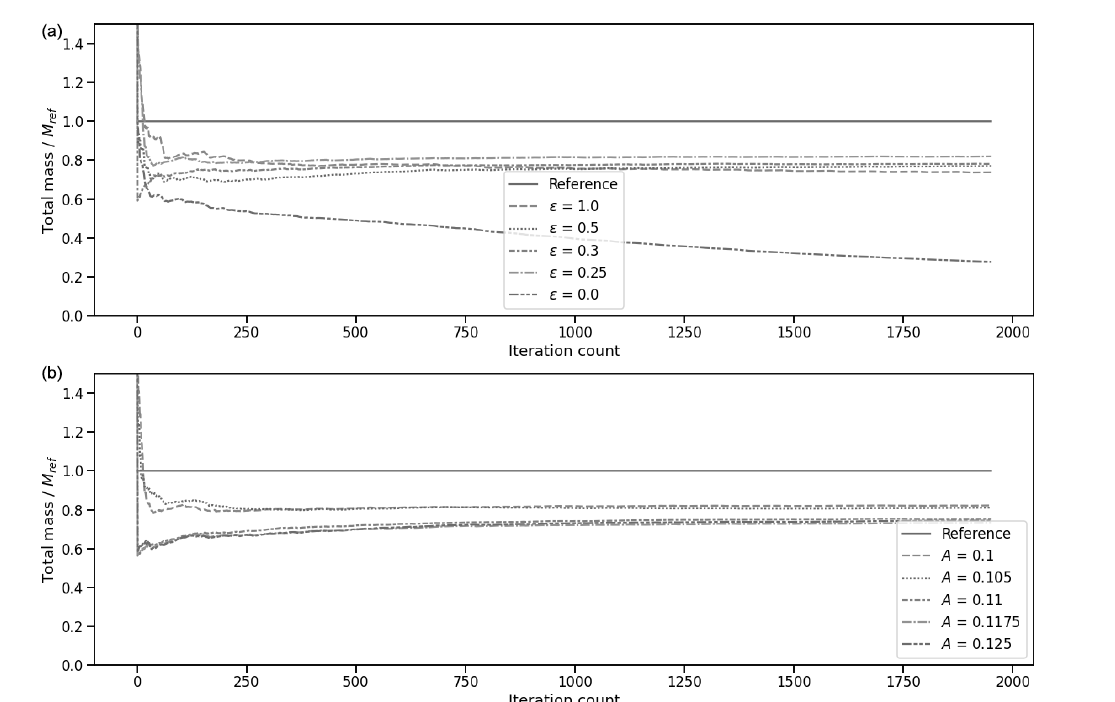
Figure 6. Flow fields at t = 2 . 5s for two double-gyre simulations with (a) (cid:15) = 0 . 1 and (b) (cid:15) = 0 . 5.